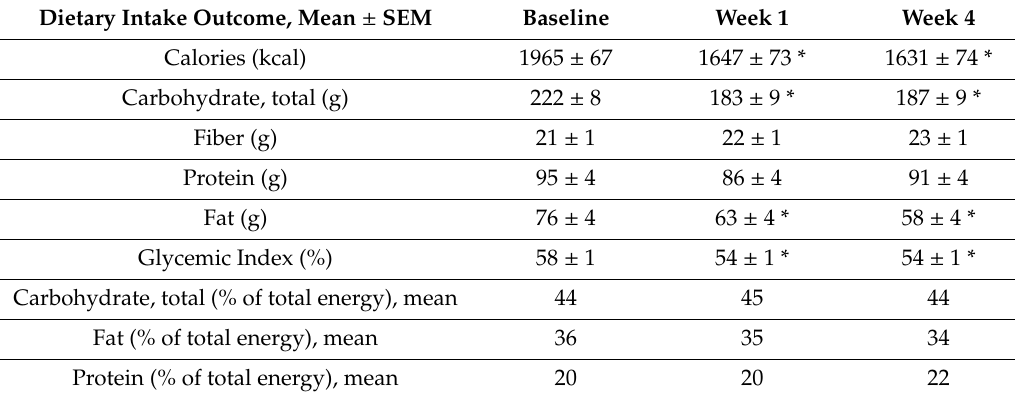
Table 2. Participant energy and nutrient intake data at baseline and week 1 and 4 post-education from the 3-day diet records.